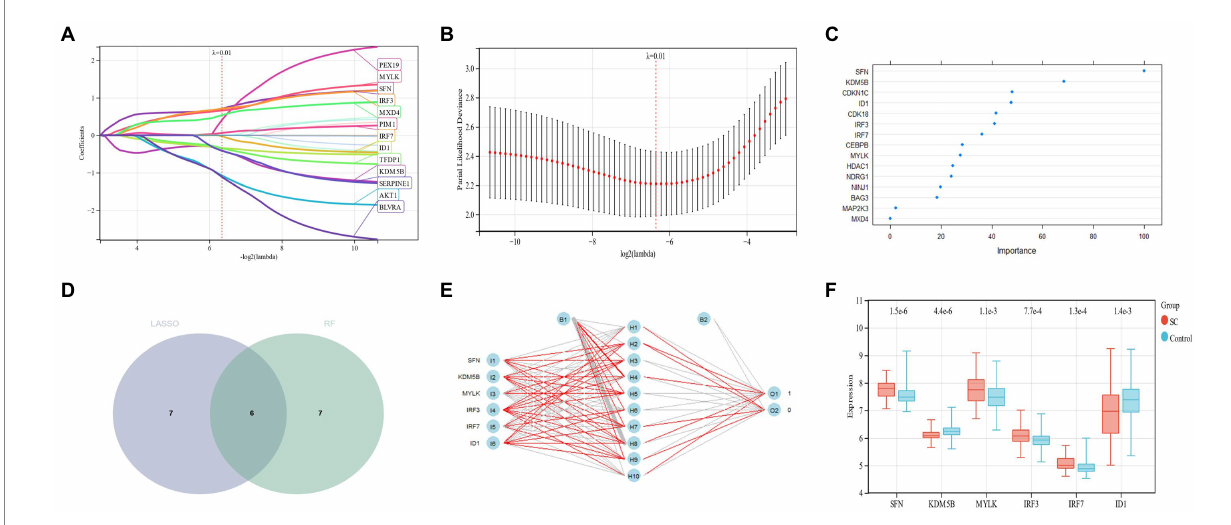
FIGURE 6 (A,B) Candidate gene screening of LASSO regression; (C) : Screening of RF candidate genes; (D) : Two kinds of machine learning intersected genes; (E) : Artificial neural network construction; (F) : Expression profile analysis of six candidate genes.